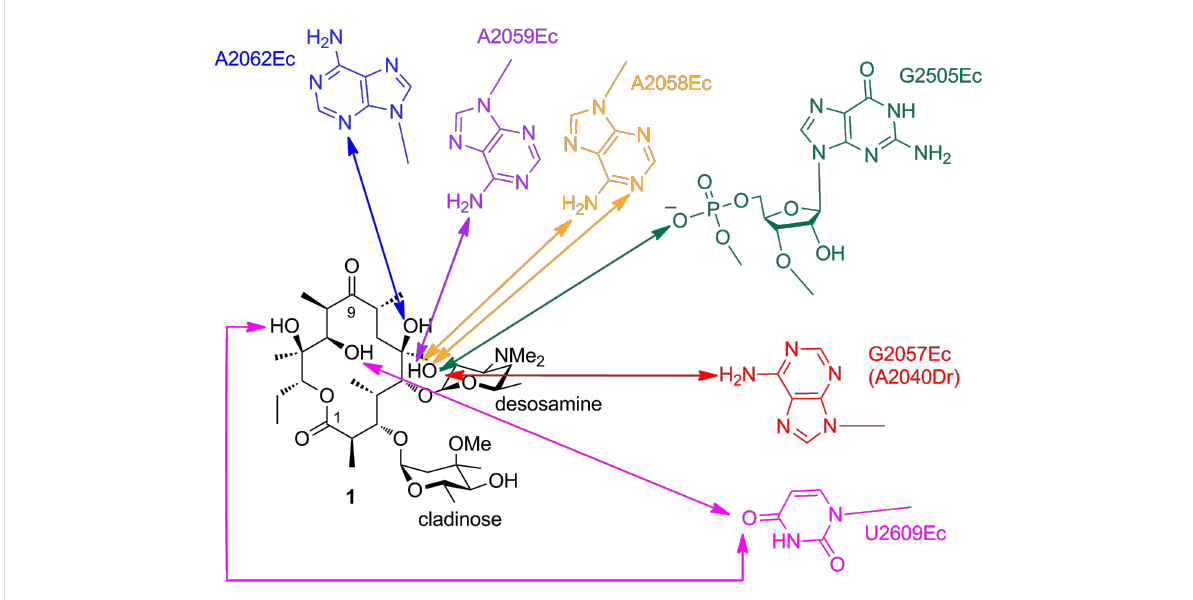
Figure 2: Schematic of erythromycin A ( 1 ) bound to 23S ribosomal RNA of the 50S subunit of the Deinococcus radiodurans (Dr) ribosome. The inter- actions between the polyketide and the nucleotides ( Escherichia coli (Ec) numbering) are indicated with colored arrows (reactive groups are less than 4.4 Å apart). Adapted from